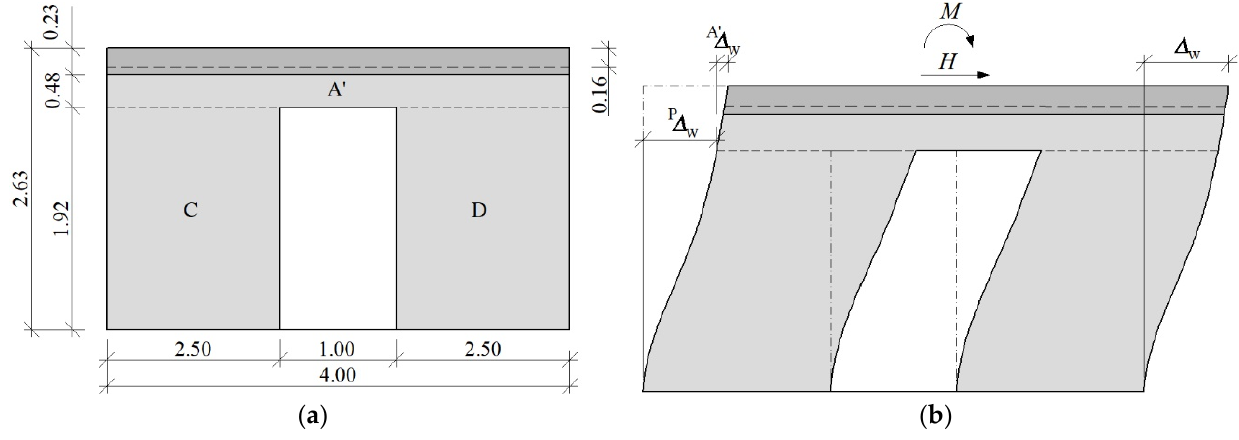
Table 7. Stiffness of walls subjected to shear with bending.